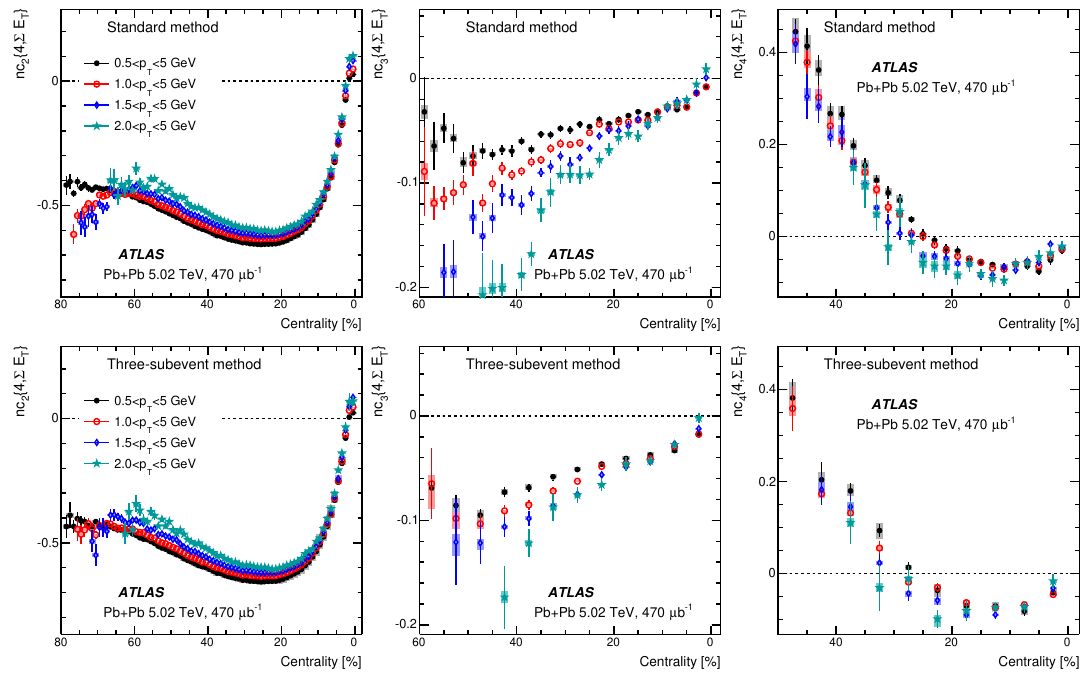
Figure 4 . The centrality dependence of normalized four-particle cumulants nc 2 f 4 ; (cid:6) E T g (left panel), nc 3 f 4 ; (cid:6) E T g (middle panel), and nc 4 f 4 ; (cid:6) E T g (right panel) obtained with the standard method (top row) and the three-subevent method (bottom row) for four p T ranges. The error bars and shaded boxes represent the statistical and systematic uncertainties, respectively. Zero is indicated by a dotted